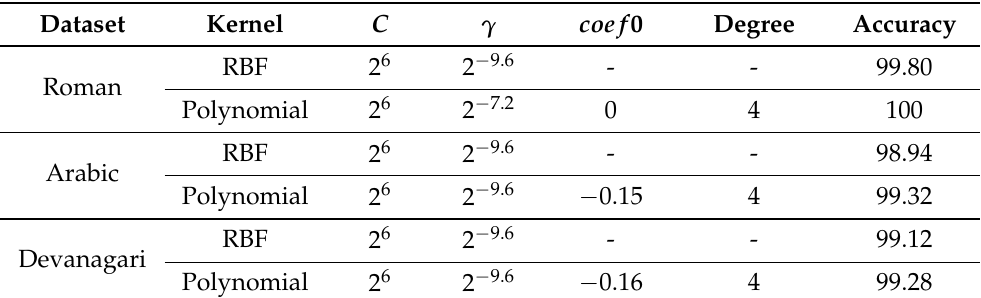
Table 2. Comparing the polynomial and RBF kernels coefficients based on the SVM method for Roman, Arabic, and Devanagari